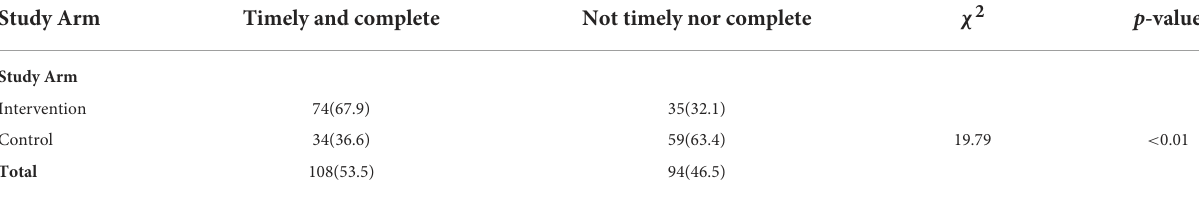
TABLE 2 Differences in vaccination timeliness and completion among infants in the intervention and control groups from selected urban slums communities in Ibadan,